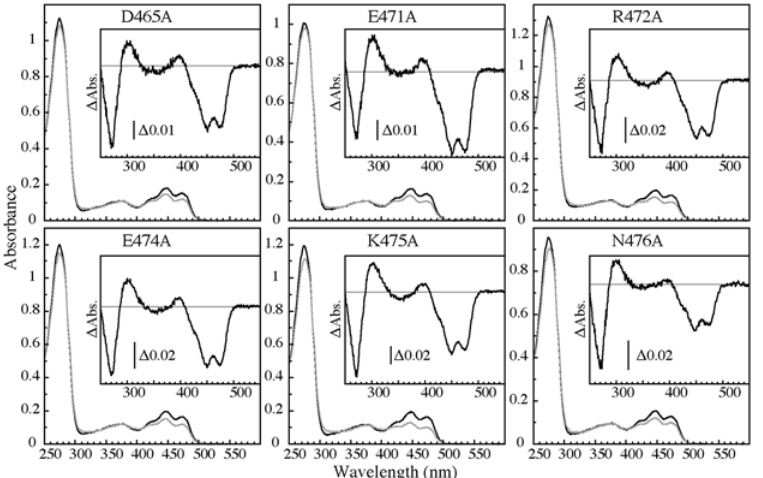
Fig 4. Absorption spectra and of the amino acid substitutes of At phot1 LOV2-STK in a solution containing 20 mM Tris-HCl, pH 7.8, 100 mM NaCl, 10% (w/v) glycerol, and 1 mM Na2EGTA at 20°C. The black and the gray line were measured after dark adaptation and BL irradiation, respectively. The insets show the light minus dark absorption difference spectra.